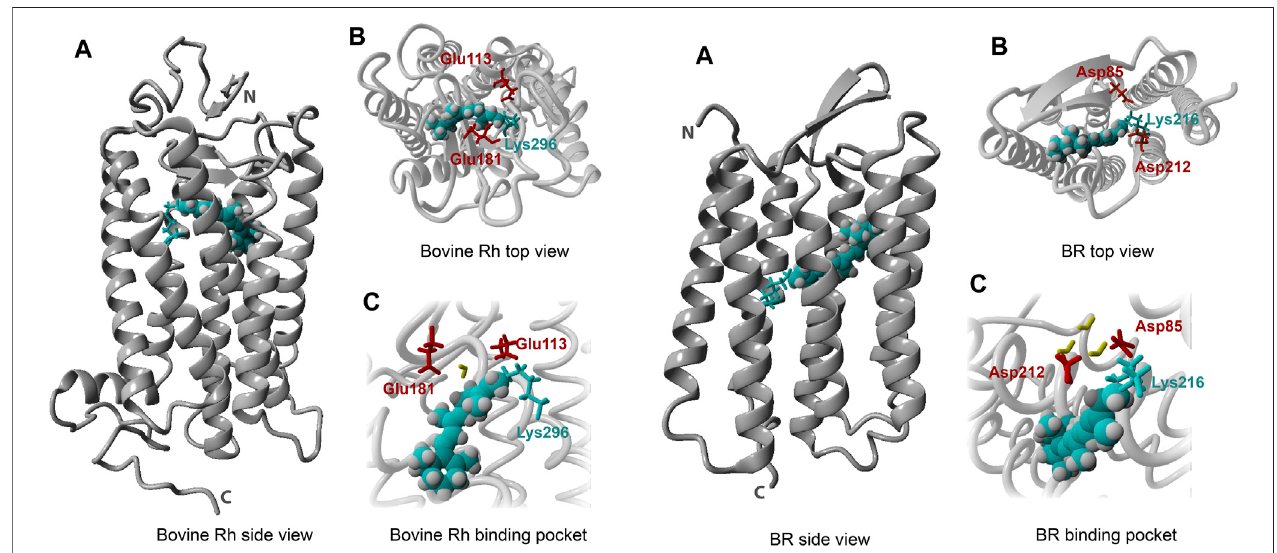
FIGURE 6 | Comparison of structural features of the type-2 and type-1 pigment archetypes bovine rod rhodopsin (left section) and bacteriorhodopsin (right section), respectively. Full crystal structures are presented in (A) and (A) (pdb 1U19 and 5ZIN), a top view is shown in (B) and (B) and a binding pocket exposure in (C) and (C) ,respectively.Theretinylidenechromophore(cyan)isrepresentedasspace- fi llingspheres,andtheretinalbindinglysineresidue(cyan)ispresentedassticks.The two protein residues displayed (red) contribute to the counterion complex stabilizing the pronated Schiff base. The two crystal structures share the seven α -helical transmembrane segment bundle, but the packing of the helices, the location and assembly of the binding pocket and the structure of the chromophore are clearly different.